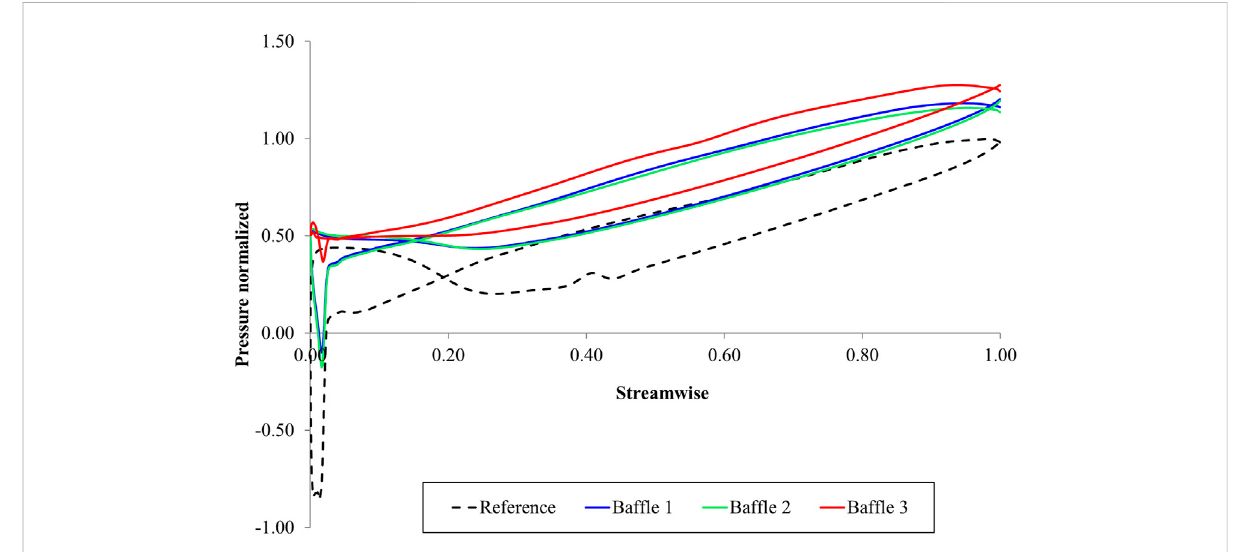
FIGURE 8 Blade loading comparison of the second stage impeller at Q BEP